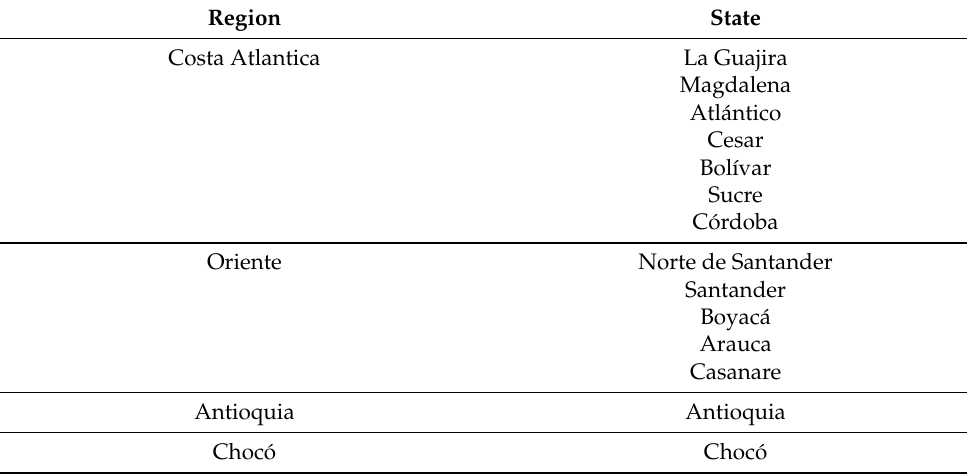
Table A1. Grouping of states into